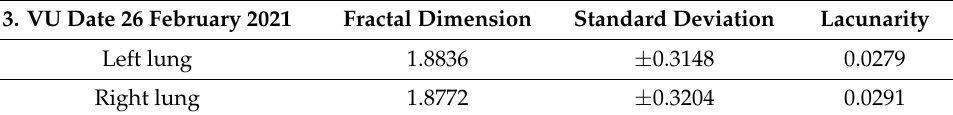
Figure 11. Three-dimensional graphical representation of voxels in the second patient(cid:31)s CT lung image. Table 3. Fractal indicators for the third patient.